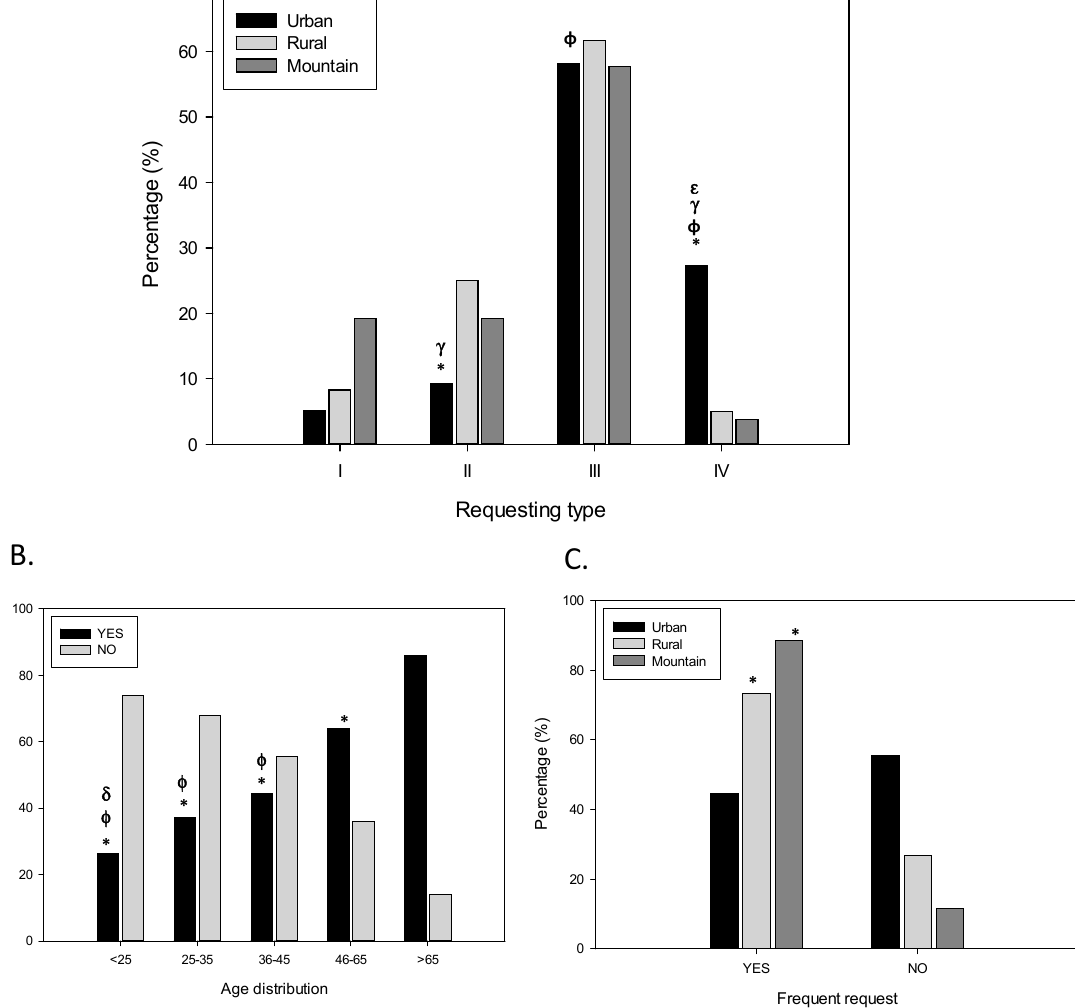
Figure 3. Drug-requesting behaviour of patients. Distribution of the participants according to ( A ) type of request and type of pharmacy, ( B ) repeated demand and age, and ( C ) frequent request and type of pharmacy. Requesting types are as follows: I, prescriptions corresponding to an over the counter (OTC) drug; II, formal prescription; III, without prescription; and finally, IV, forged prescriptions. It can be observed that the drug request behaviour depends on the type of pharmacy, the repeated demand depends on age and that the frequent request is produced at higher levels in rural or mountain pharmacies. proportions are calculated from each condition related to 548 notifications analysed. Statistical differences: